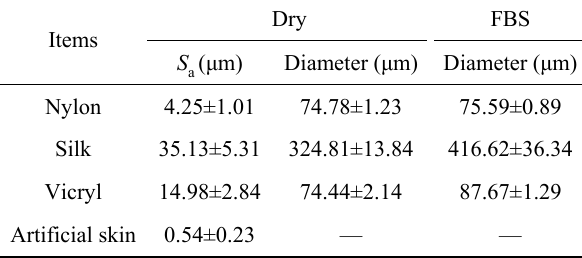
Table 1 Surface roughness and diameter of the sutures.